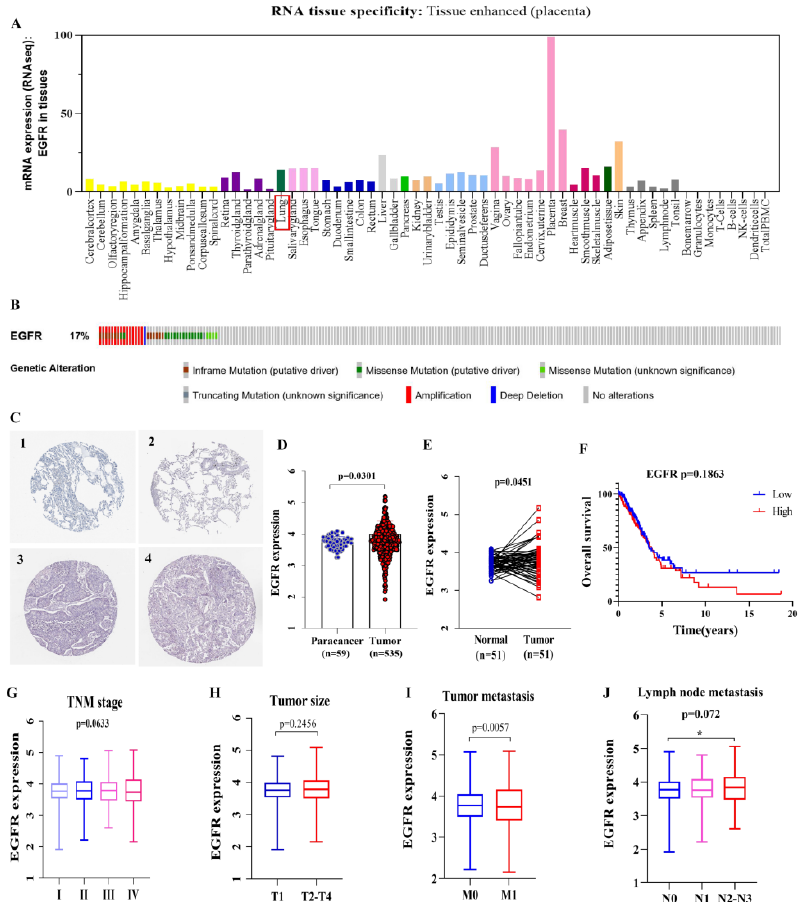
Figure 1. High expression of EGFR in LUAD and prognostic value. ( A ) EGFR expression distribution in whole cancer tissues. ( B ) cBioPortal OncoPrint plot displaying the distribution of EGFR genomic alterations rate in LUAD dataset. ( C ) Validation of EGFR expression at the translational level by HPA database, normal tissue (1 & 2), and tumor tissue (3 & 4). ( D , E ) EGFR expression in tumor- paracancer paired and tumor-normal samples. ( F ) The low expression ( n = 243) and high expression ( n = 244) of EGFR were compared by the Kaplan–Meier survival curve. ( G ) Correlation of EGFR expression with TNM stage, stage I, n = 272; stage II, n = 119; stage III, n = 84; stage IV, n = 25. ( H ) Correlation between EGFR expression and tumor size, T1, n = 166; T2-T4, n = 337. ( I ) Correlation between EGFR expression and tumor lymph node metastasis, M0, n = 339; M1, n = 23. ( J ) Correlation between EGFR expression and distant metastases, N0, n = 325; N1, n = 93; N2-N3, n = 76. The RNAs expression value was logarithmized with log10. Statistically significant differences between the two groups of data were estimated by the Mann–Whitney test and independent t-test. One-way ANOVA was used to assess statistical differences between multiple groups of data. A * p < 0.05. p < 0.05 was considered statistically significant.